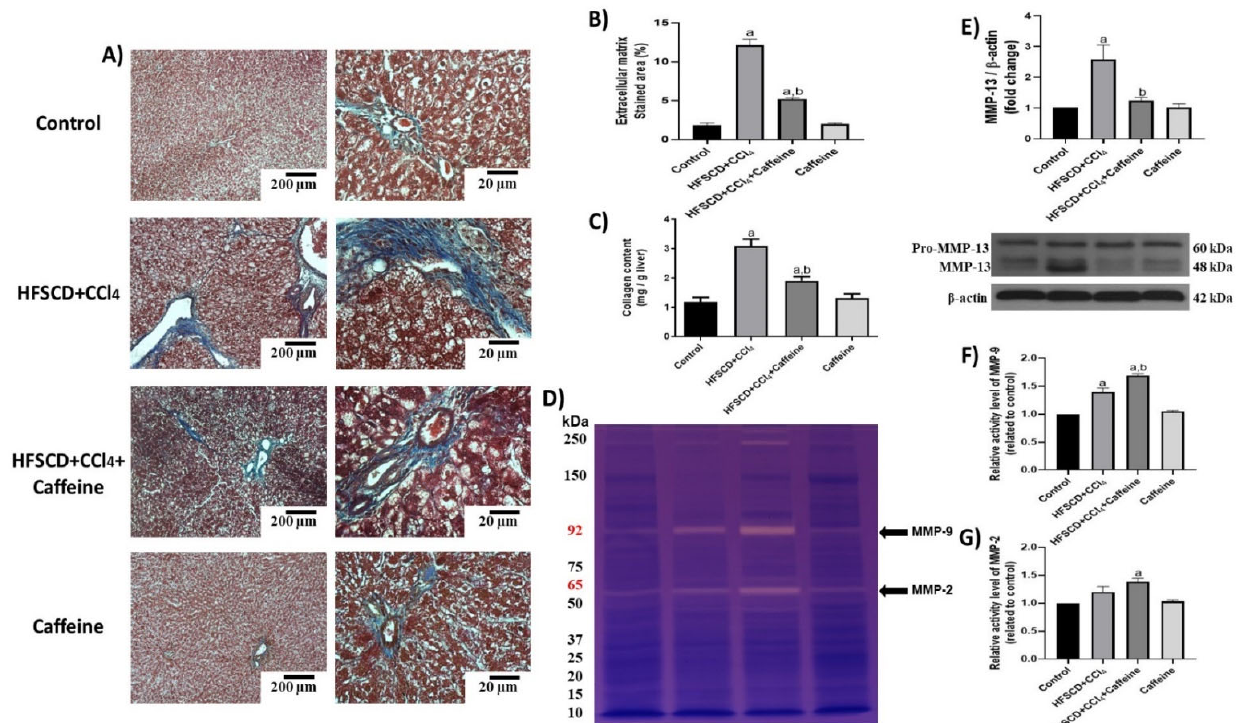
Figure 7. Effect of caffeine on fibrosis and profibrogenic mediators and MMPs in hepatic tissue from the NASH model. ( A ) Masson’s trichrome staining in hepatic tissues from rats in the control, HFSCD+CCl 4 , HFSCD+CCl 4 +caffeine, and caffeine groups. Scale bars = 200 and 20 μ m. ( B ) Percentages of collagen areas (n = 4). ( C ) Collagen content was determined by measuring the liver hydroxyproline level (n = 6). Activities of MMP ‐ 9 ( F ) and MMP ‐ 2 ( G ) were determined using zymography ( D ) (n = 5). Bars represent the mean ± SEM. Values are shown as fold increments in optical density normalized to control group values (control = 1). ( E ) Protein level of MMP ‐ 13 was examined using western blot analysis (n = 3); β‐ actin was used as a loading control. Bars represent the mean ± SEM. (a) p < 0.05 compared with the control group; (b) p < 0.05 compared with the HFSCD+CCl 4 group.